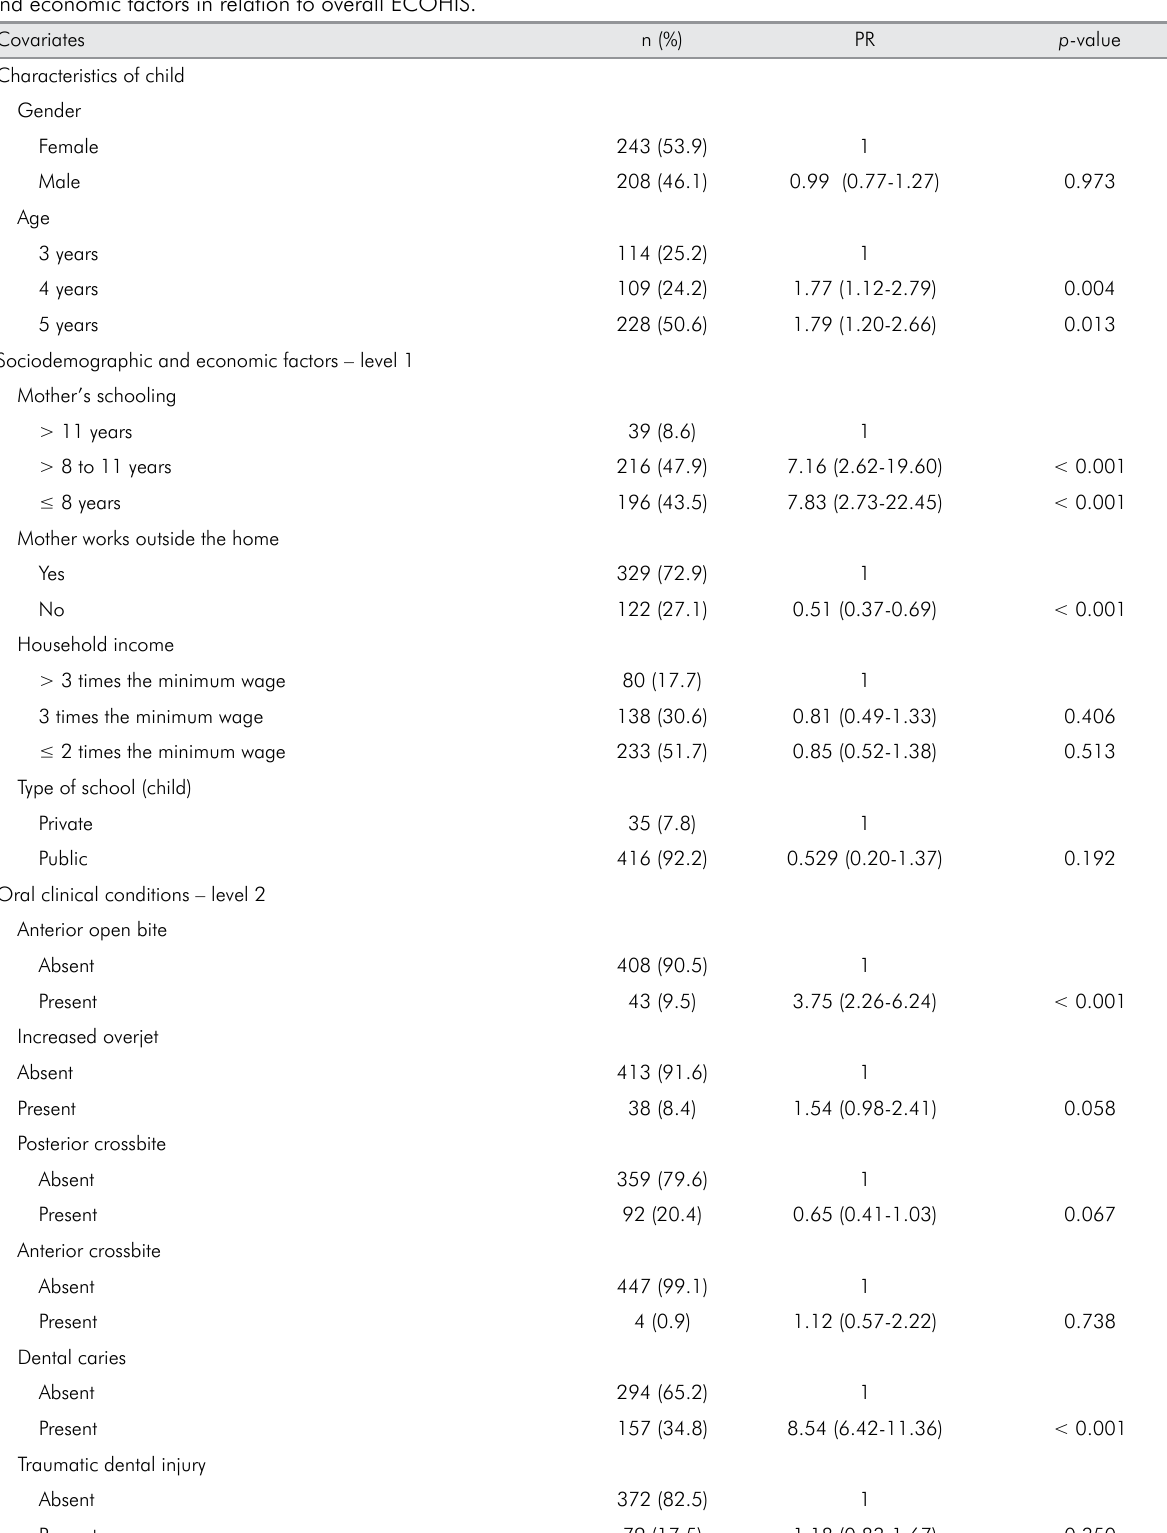
Table 2. Univariate analysis of associations among oral clinical conditions, characteristics of children, and both sociodemographic and economic factors in relation to overall